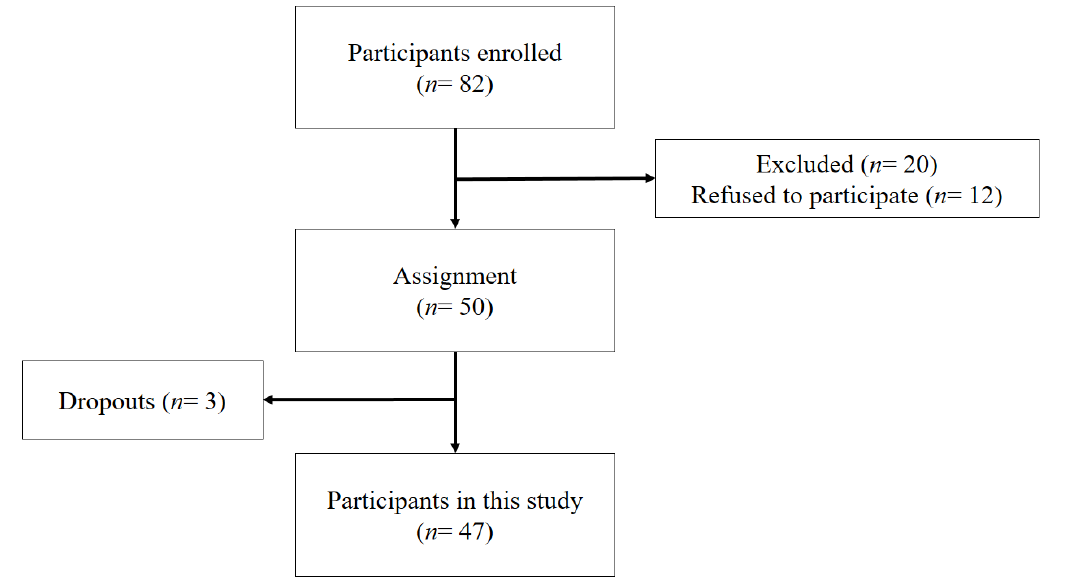
Figure 1. Flowchart of participants.